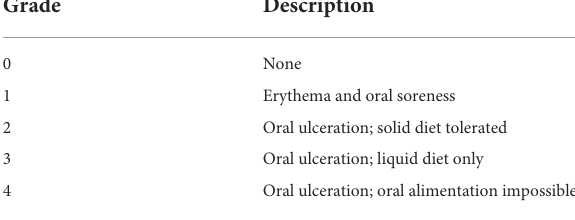
TABLE 1 World Health Organization Scale (WHO) for scoring oral mucositis.